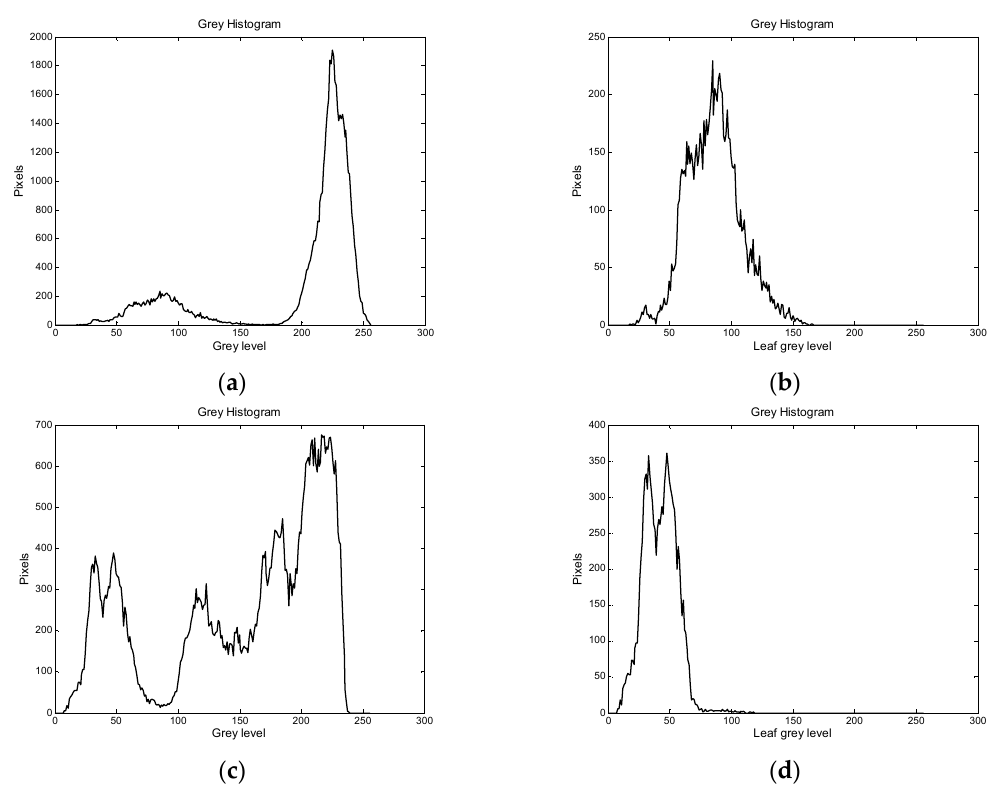
Figure 2. Gray histogram of ( a ) an image with a citrus leaf infected by the fungus A. citri ( Alternaria ) or ( b ) of the citrus leaf only. Gray histogram of ( c ) an image with a citrus leaf infected by the fungus Diaporthe citri of melanose or ( d ) of the same citrus leaf only.